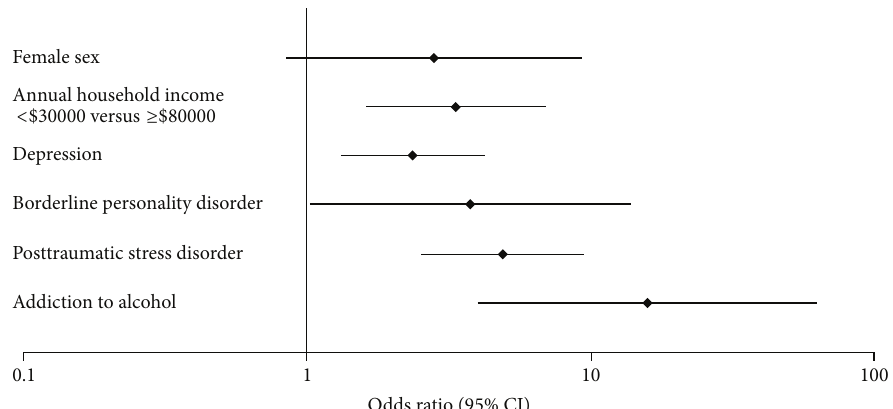
Figure 1: Significant predictors of sexual abuse: multivariable logistic regression analysis. Estimates adjusted for age, BMI, and all variables listed in the figure: female sex, annual household income of less than $30 000 compared to $80 000 or more, depression, borderline personality disorder, posttraumatic stress disorder, and addiction to